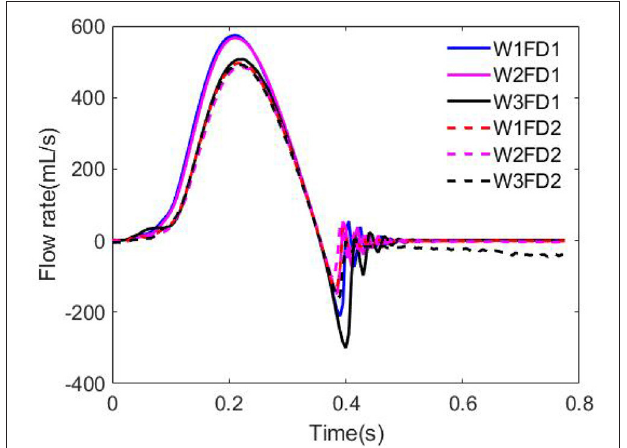
Table 6 . At the open state, the average stresses of the two regions are negative that is because of compression, in which the cases with FD2 have the larger compressed stress level than FD1 in the top-center region, while the cases with W2 have the largest compressed stress level in the belly region. Moreover, at the closed state, the cases with FD1 have a larger stress level in the